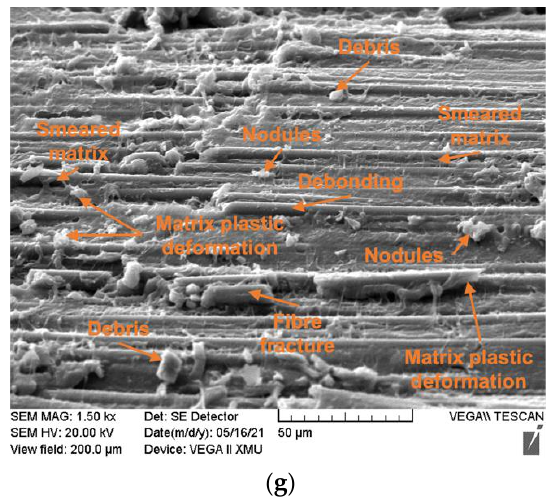
Figure 6. The SEM images of the fracture surfaces of the on-axis and off-axis specimens under compressive loads: ( a ) 0° axial compression; ( b ) 15° off-axis compression; ( c ) 30° off-axis compression; ( d ) 45° off-axis compression; ( e ) 60° off-axis compression; ( f ) 75° off-axis compression; ( g ) 90° on-axis transverse compression.